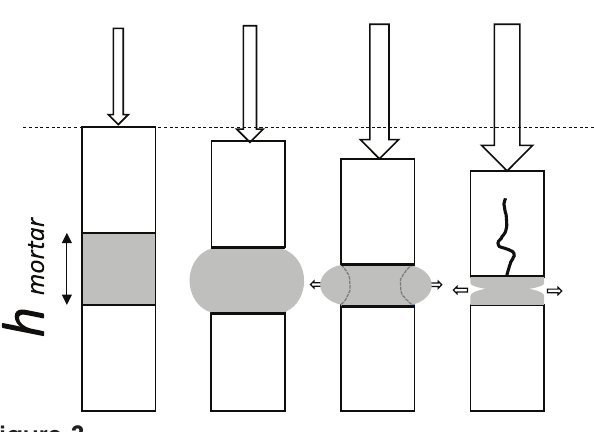
Failure mechanism of prism with weak mortar